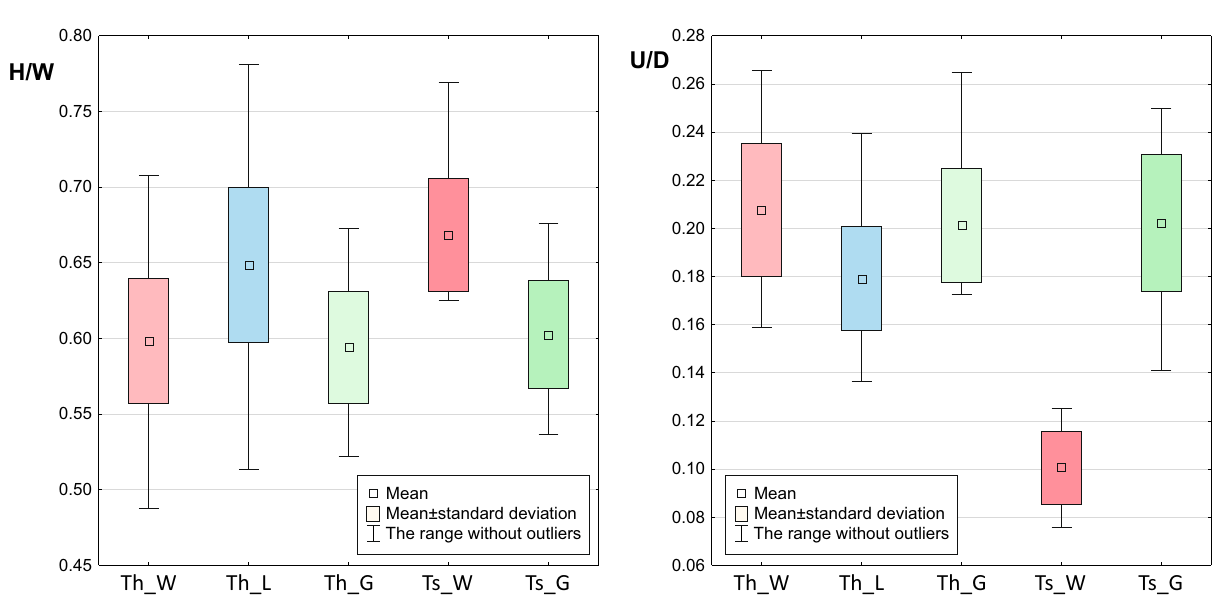
Figure 7. Boxplots of selected morphometric features, height/width ratio (H/W) and umbilicus relative diameter (U/D), for five groups of Trochulus : parental T. hispidus from wild habitat in Wrocław (Th_W), the first generation of T. hispidus bred in laboratory (Th_L); T. hispidus raised in garden in Wrocław (Th_G); T. sericeus from wild habitat in Muszkowice (Ts_W); T. sericeus raised in garden in Wrocław